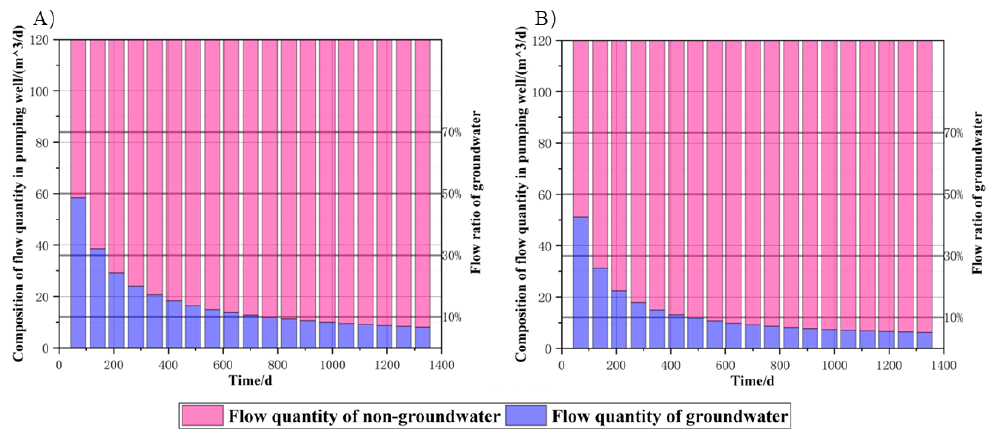
Figure 11. The bar graph of the composition of flow quantity in the pumping well at the whole C1 and C2 mining areas with the change in time (based on the average concentration from all pumping wells). Note: ( A ) ‐ Plan D; ( B ) ‐ Plan E. Table 3. Comparison of the day for plan D and plan E to reach the corresponding “flow ratio of groundwater”.